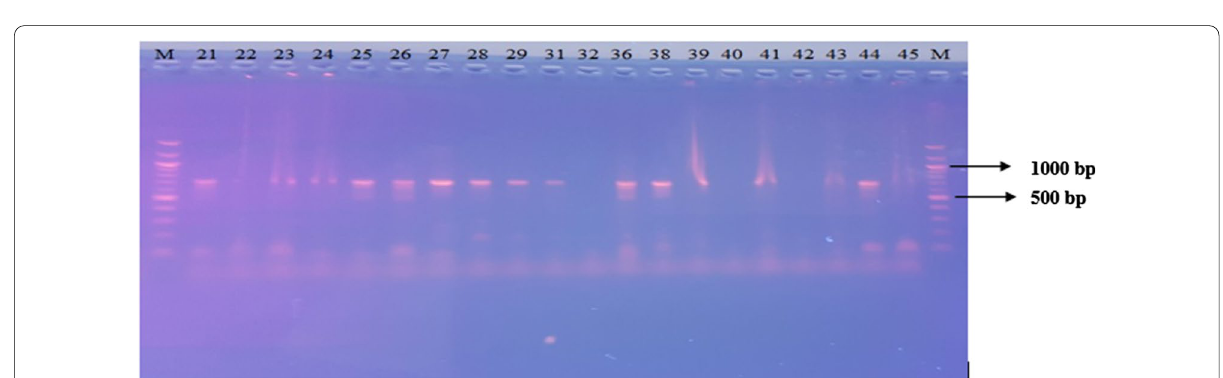
Fig. 2 Amplification profile of mosquito species with primers from the COI gene region. M